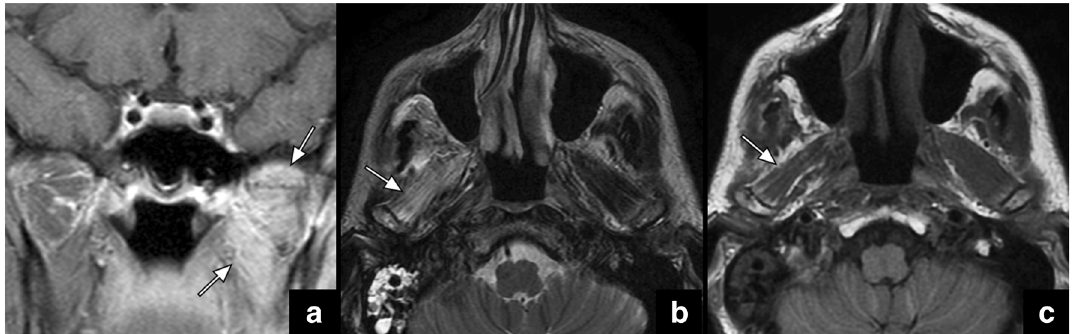
Fig. 7 Coronal contrast-enhanced T1-weighted image ( a ) shows marked enhancement of left pterygoid muscles ( between arrows in a ) indicative ofacute denervationofthe muscles supplied by themotoric branch ofV3. On an axial T2 weighted image in a different patient ( b ), the denervated muscles show marked hyperintensity ( arrow in b ) due to oedema in the acute phase and due to fatty replacement in the chronic phase. Muscular